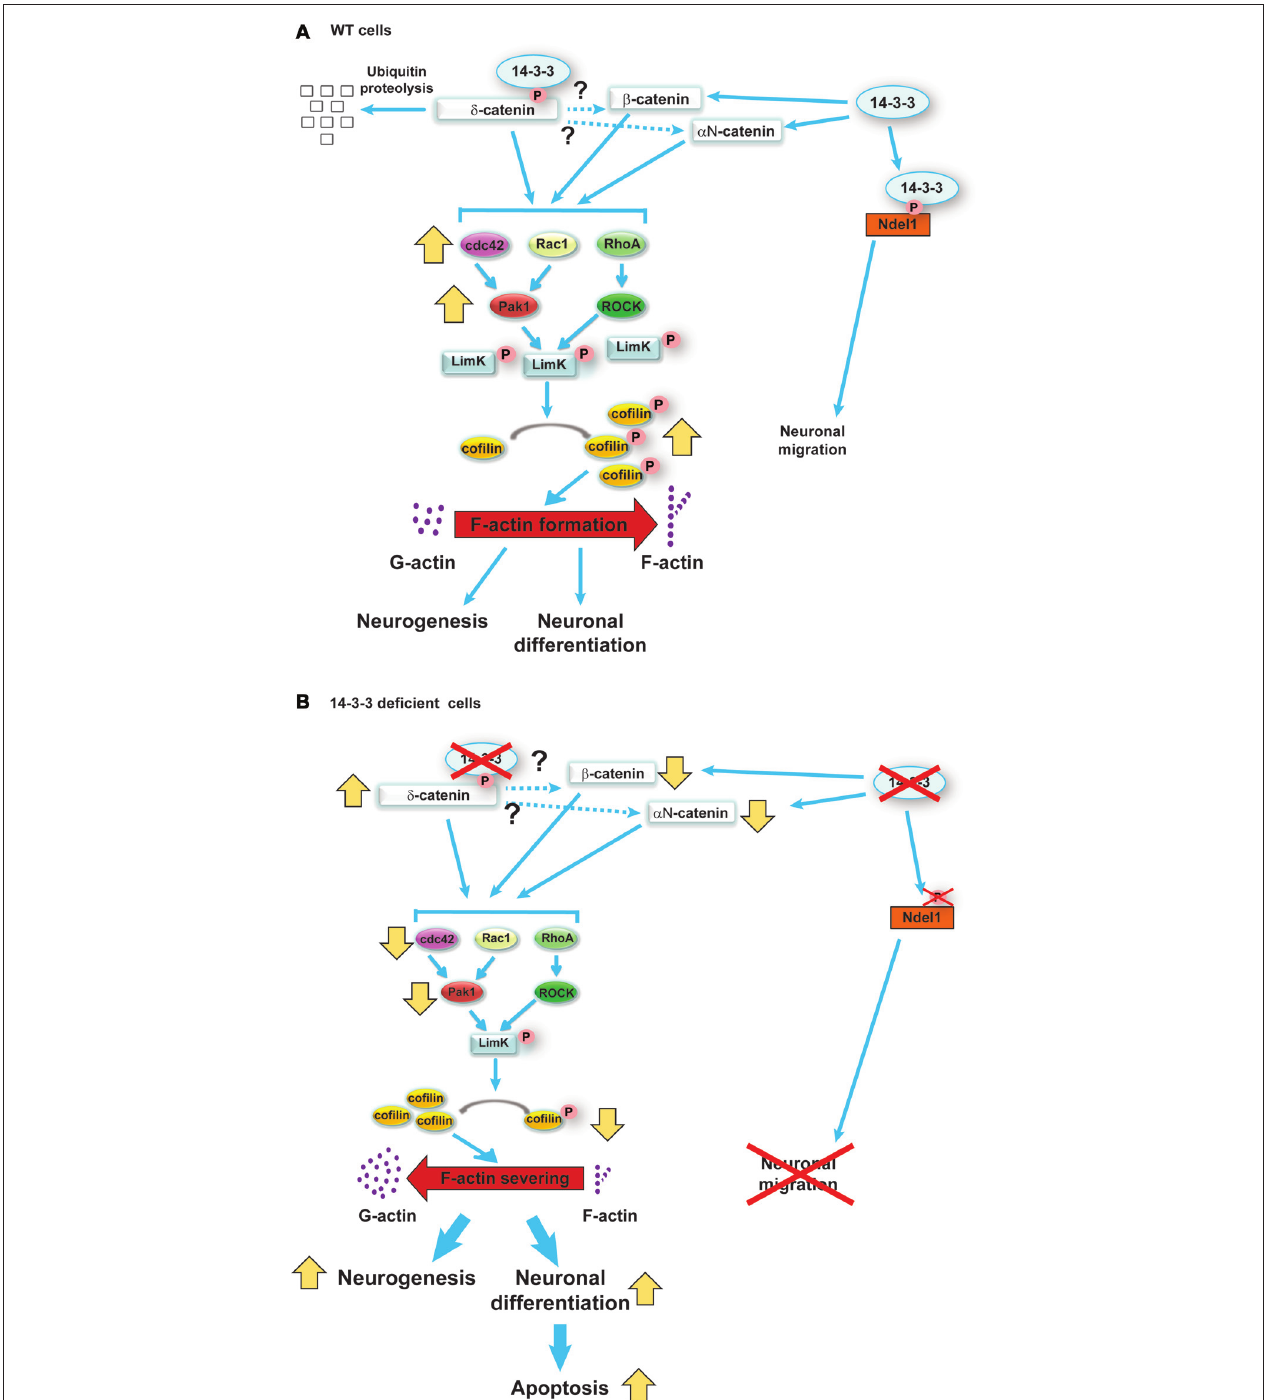
FIGURE 3 | Schematic model of the functions of 14-3-3 ε and 14-3-3 ζ in neurogenesis and neuronal differentiation during cortical development, reproduced with permission from the Society for Neuroscience (Toyo-Oka et al., 2014). (A) In wild-type (WT) progenitor cells, 14-3-3 ε and ζ interact with δ -catenin and regulate its ubiquitination and subsequent degradation. δ -catenin then may regulate the stability of β -catenin and α N-catenin (dotted lines). The catenin proteins then activate the Rho family of GTPases, which in turn results in the phosphorylation of Limk1 through Pak and ROCK proteins. Then, phosphorylated Limk1 phosphorylates cofilin. Phosphorylated cofilin is inactive and will not sever F-actin, resulting in accelerated F-actin formation. (B) In contrast, when the progenitor cells are deficient in 14-3-3 ε and ζ , the δ -catenin protein levels increase. This results in an opposite cascade of events resulting in increased neurogenesis and neuronal differentiation as well as defects in the subsequent neuronal